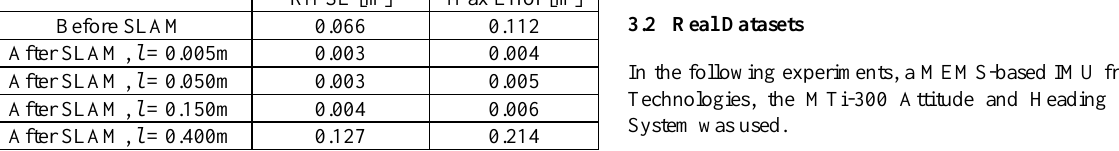
Table 4: Error in estimated trajectory when using the wrong l Small errors in l do not have a significant impact on the SLAM solution. While GP-SLAM does not appear to be hypersensitive to the neighbourhood radius, it is better to underestimate l than to overestimate; this is likely because it is better to ignore measurements